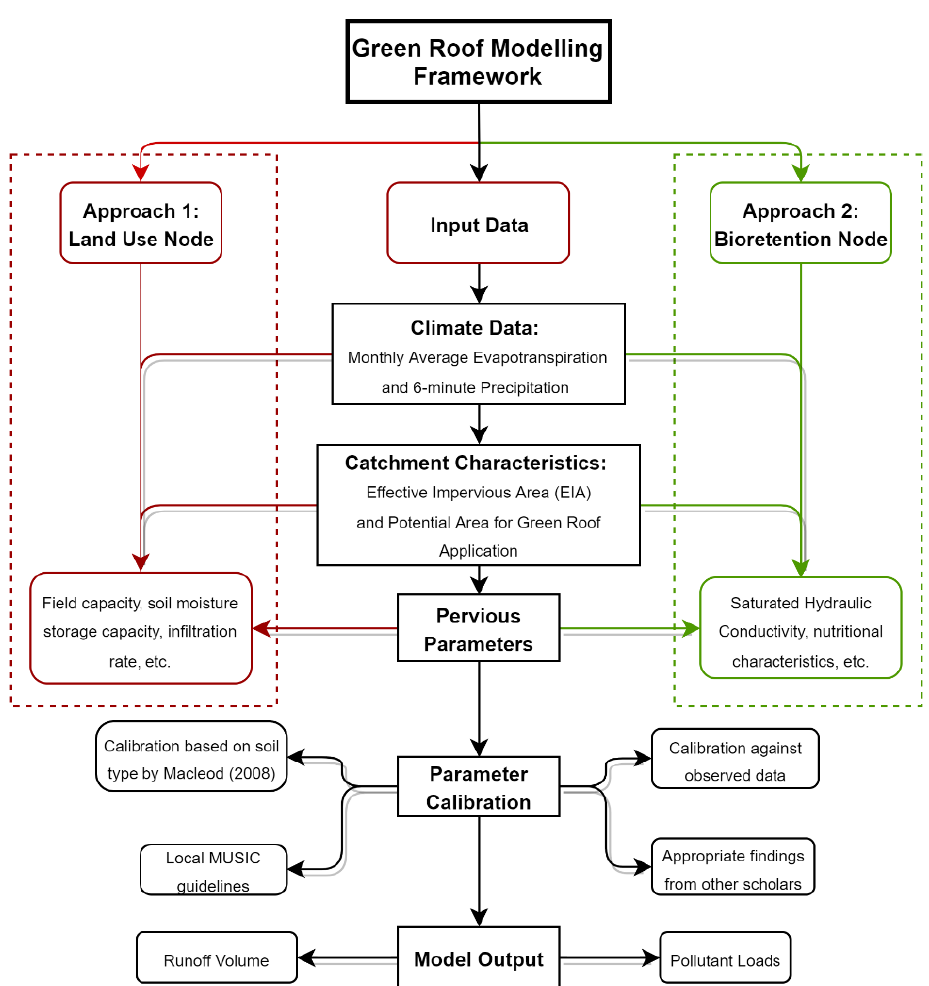
Figure 3. A framework for evaluating the performance of large-scale green roofs in terms of runoff quantity and quality .